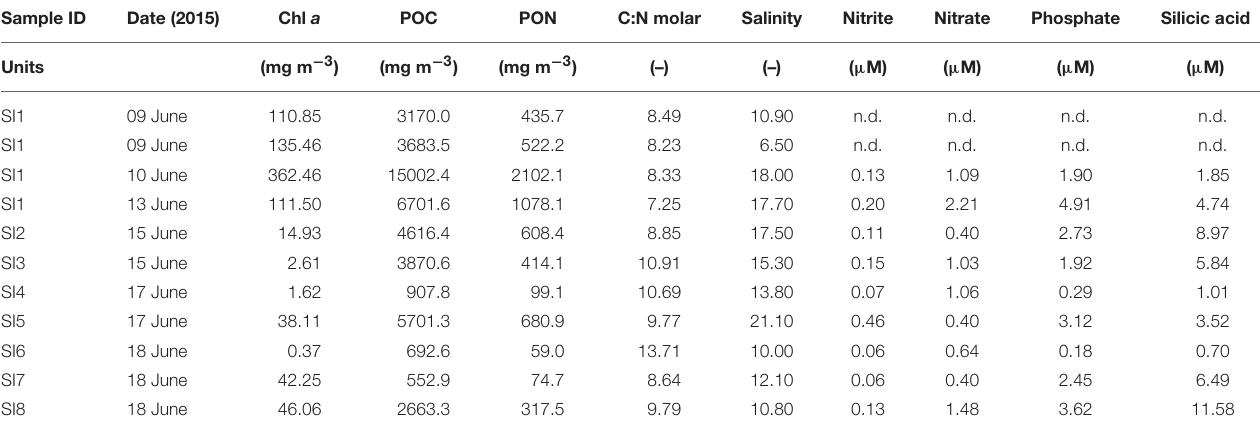
TABLE 2 | Compilation of biogeochemical parameters of the snow-infiltration communities (SI). Sample ID